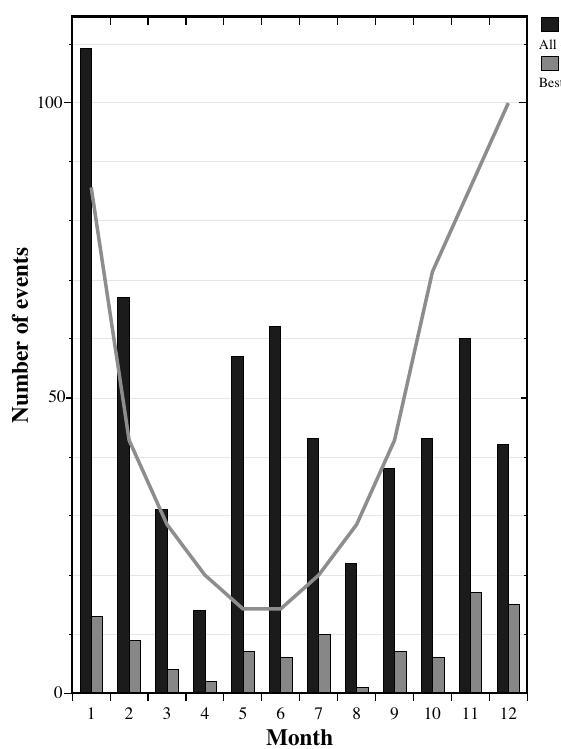
Fig. 4. The distribution of the peak energy observed within the inverted-V’s. In most cases, the accelerated energies range from 2 to 4 keV. The overlaid red curve shows a fit of an exponential function into the whole data set.